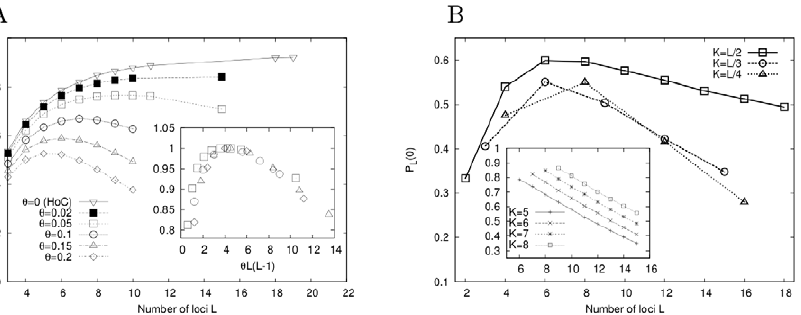
Figure 3. Accessibility in fitness landscape models with tunable ruggedness. (A) Behavior of p L (0) in the RMF model as function of the correlation parameter h . Inset shows normalized rescaled curves, all taking their maximum at h L ( L { 1) * 4 . This implies that p L (0) increases monotonically only for h : 0 . (B) Probability p L (0) for the LK model as a function of L at fixed K = L (main figure) and fixed K (inset), respectively.